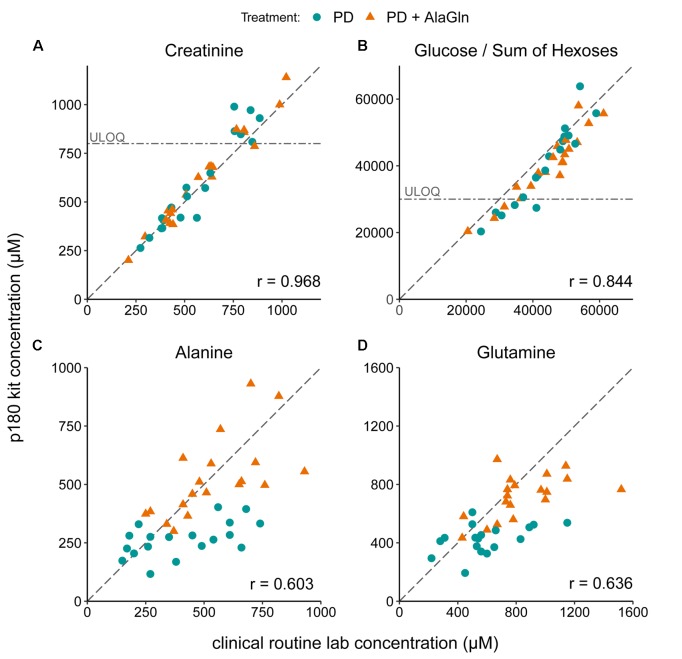
Validation of metabolomic quantitation of four metabolites by correlation with routine clinical laboratory methods. Correlations of (A) creatinine, (B) glucose, (C) alanine, and (D) glutamine concentrations with the concentrations measured in the p180 metabolomics assay (“sum of hexoses”: 90–95% glucose). Pearson’s correlation coefficients (r) are indicated. Creatinine and glucose concentrations were partly above the upper limits of quantification (ULOQ). Dashed line: line of identity for each comparison.